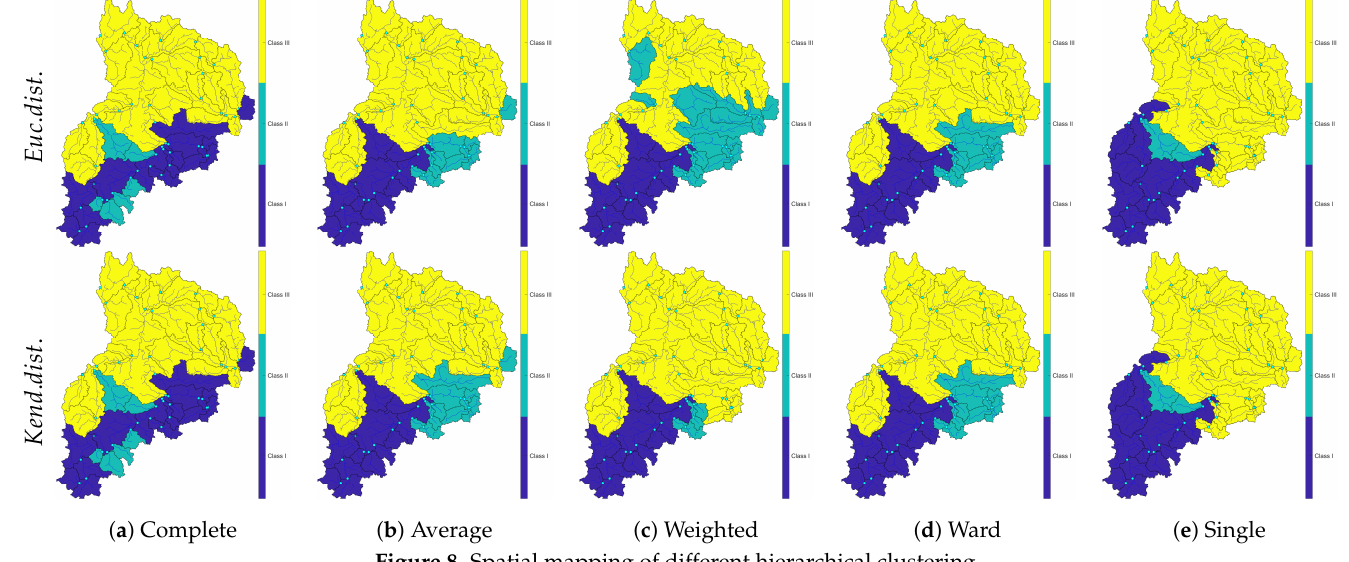
Figure 8. Spatial mapping of different hierarchical